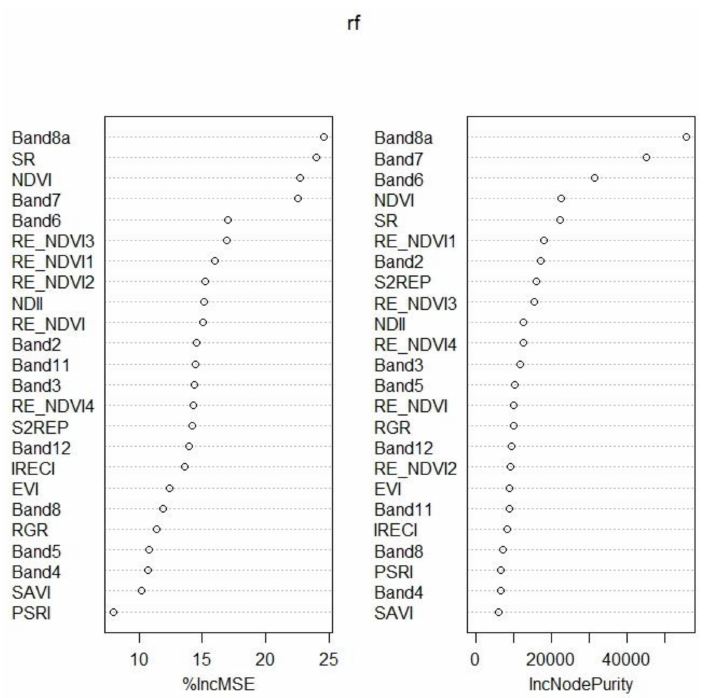
Figure 3. Relative importance of the entire prediction model.